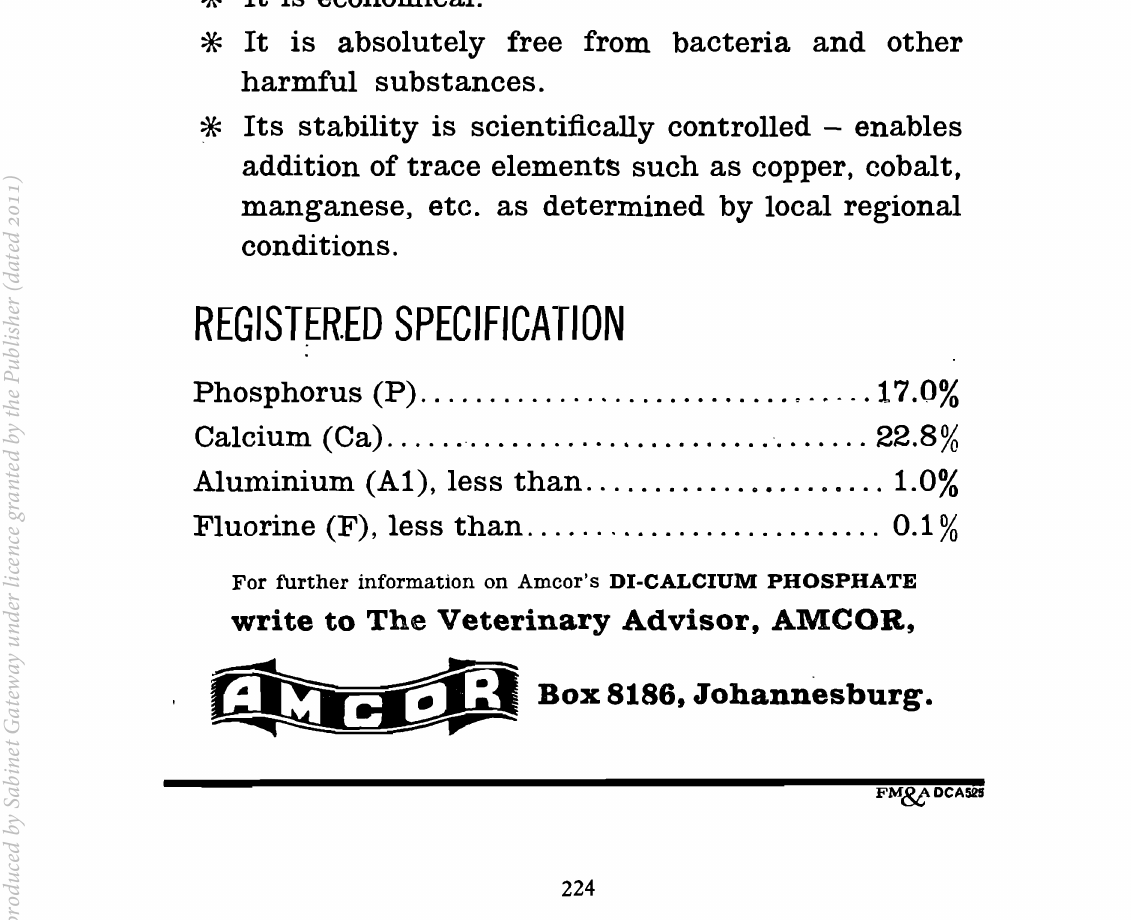
The ideal source of phosphate for rations and st9ck